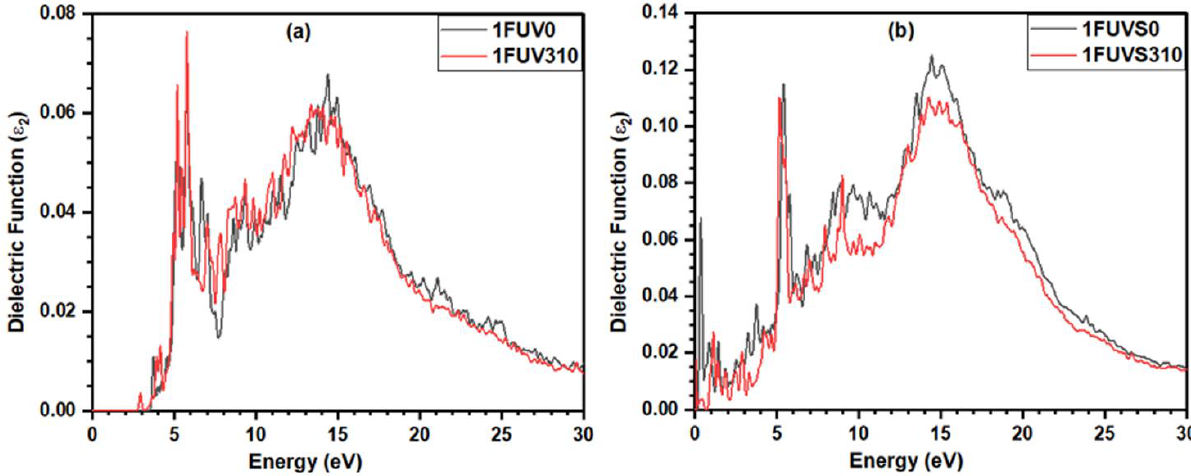
Figure 8. Calculated imaginary part of the complex dielectric function for ( a ) dry and ( b ) solvated 1FUV at 0 K and 310 K.